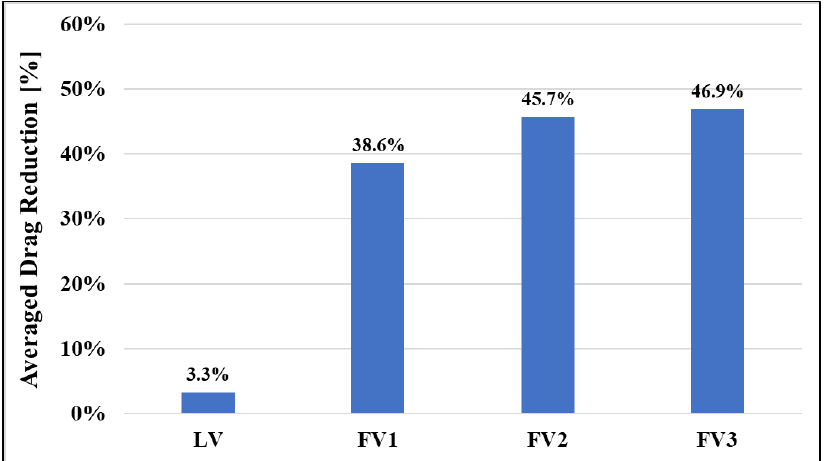
Figure 5. Reduction in the averaged C D of each vehicle in platooning compared to SV. Figure 6 shows the static pressure distribution around the vehicles platooning and it indicates that the stagnation pressure is highest at the front surface of the LV and gradually decreases for the following vehicles because the incoming air velocity decreases due to the circulation flow at the front region of each following vehicle. Table 3 shows that LV has 15% lower drag than the SV under the 0.5 L condition. It is due to the higher station pressure formed on the frontal region of FV1 which recovers the rear pressure of the LV. Additionally, the effect disappears as the gap distance